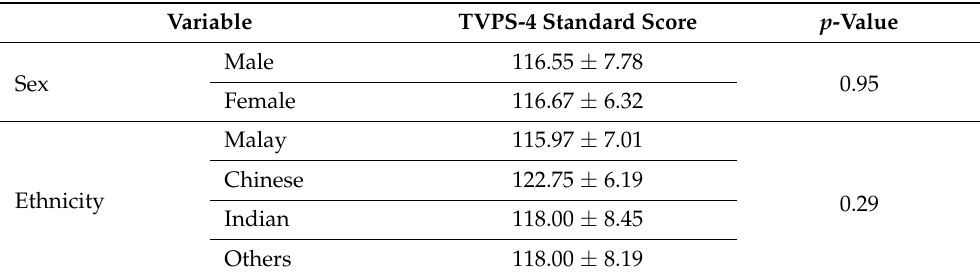
Table 2. TVPS-4 standard scores (mean ± standard deviation) based on participants’ sex and ethnicity. Variable